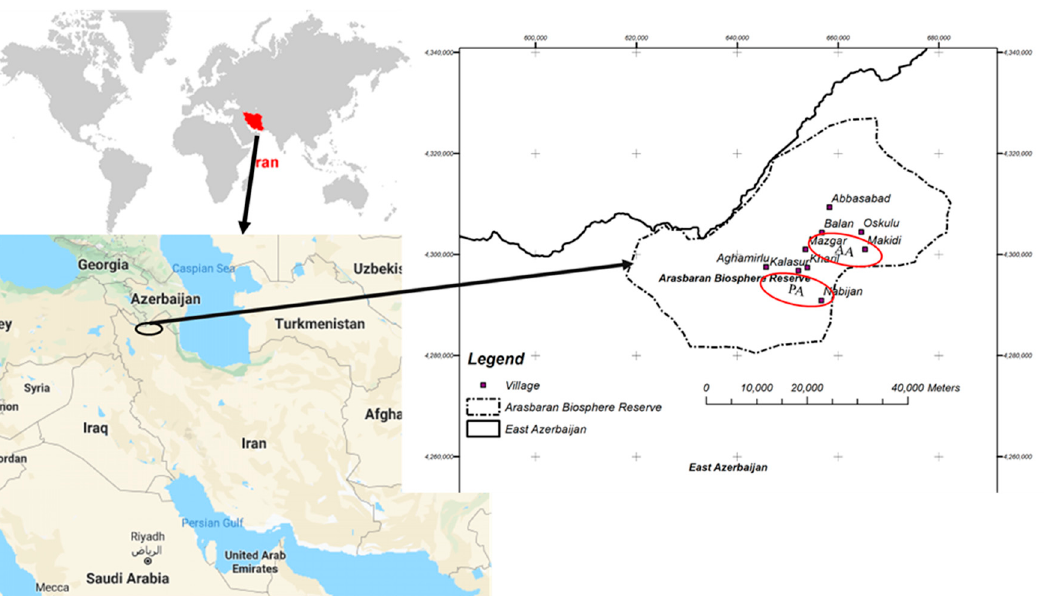
Figure 1. Map of the study area showing the presence and pseudo-absence areas of the Caucasian grouse in the Arasbaran Biosphere Reserve, NW Iran. PA—Presence area, AA—Absence/Pseudo- absence area.